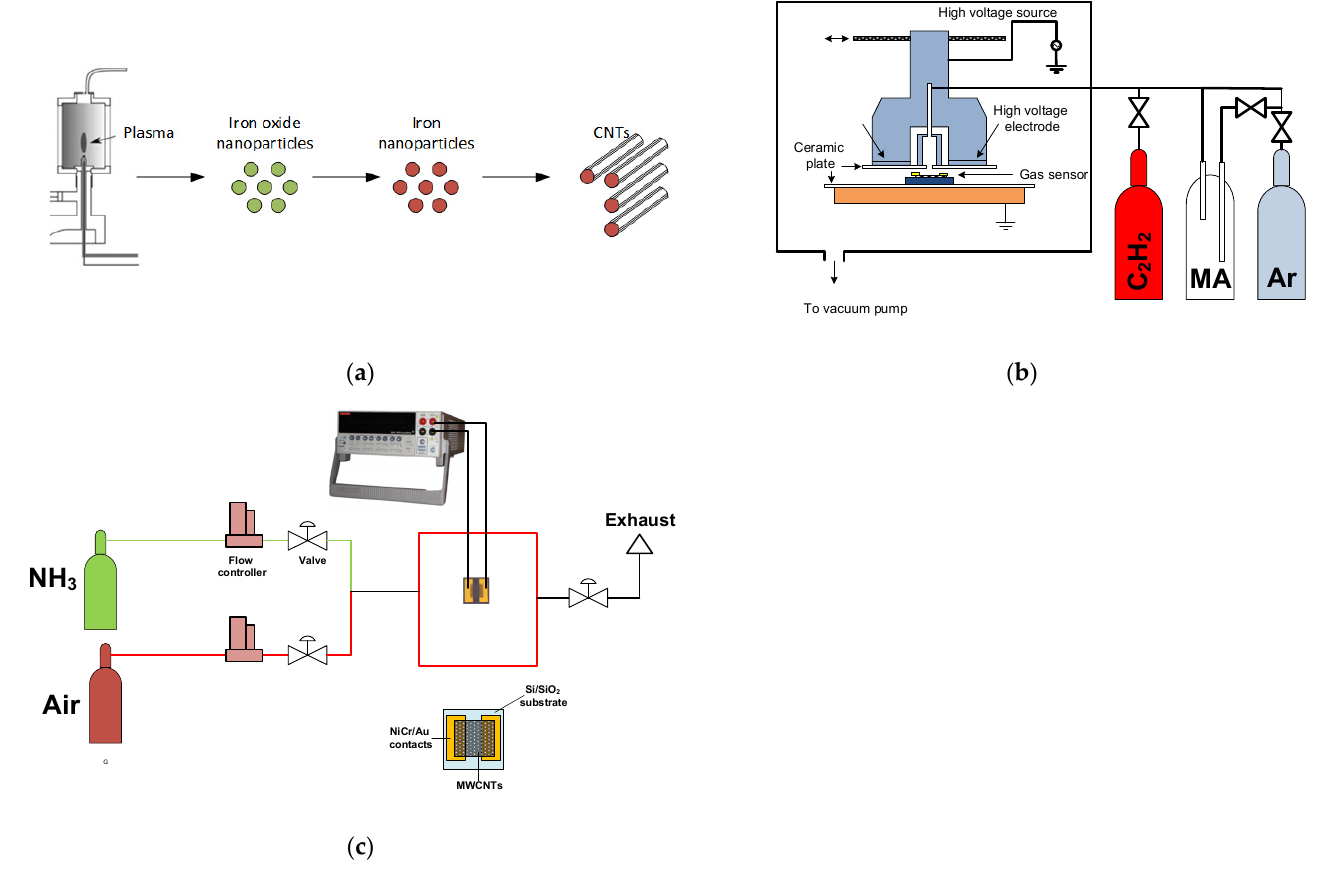
Figure 1. Scheme indicating all stages of synthesis of MWCNTs ( a ). Scheme of experimental setup for plasma treatment of MWCNTs on Si/SiO 2 sub strates ( b ). Scheme of equipment used for testing for plasma treatment of MWCNTs on Si/SiO 2 substrates ( b ). Scheme of equipment used for testing of gas sensors ( c ). of gas sensors ( c